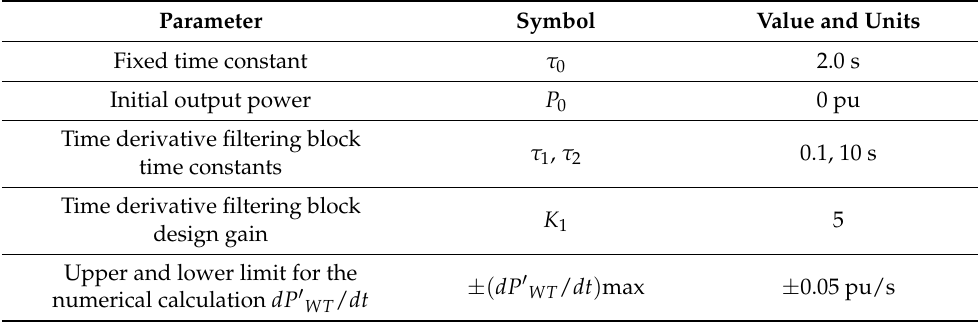
Table A2. Parameters of proposed